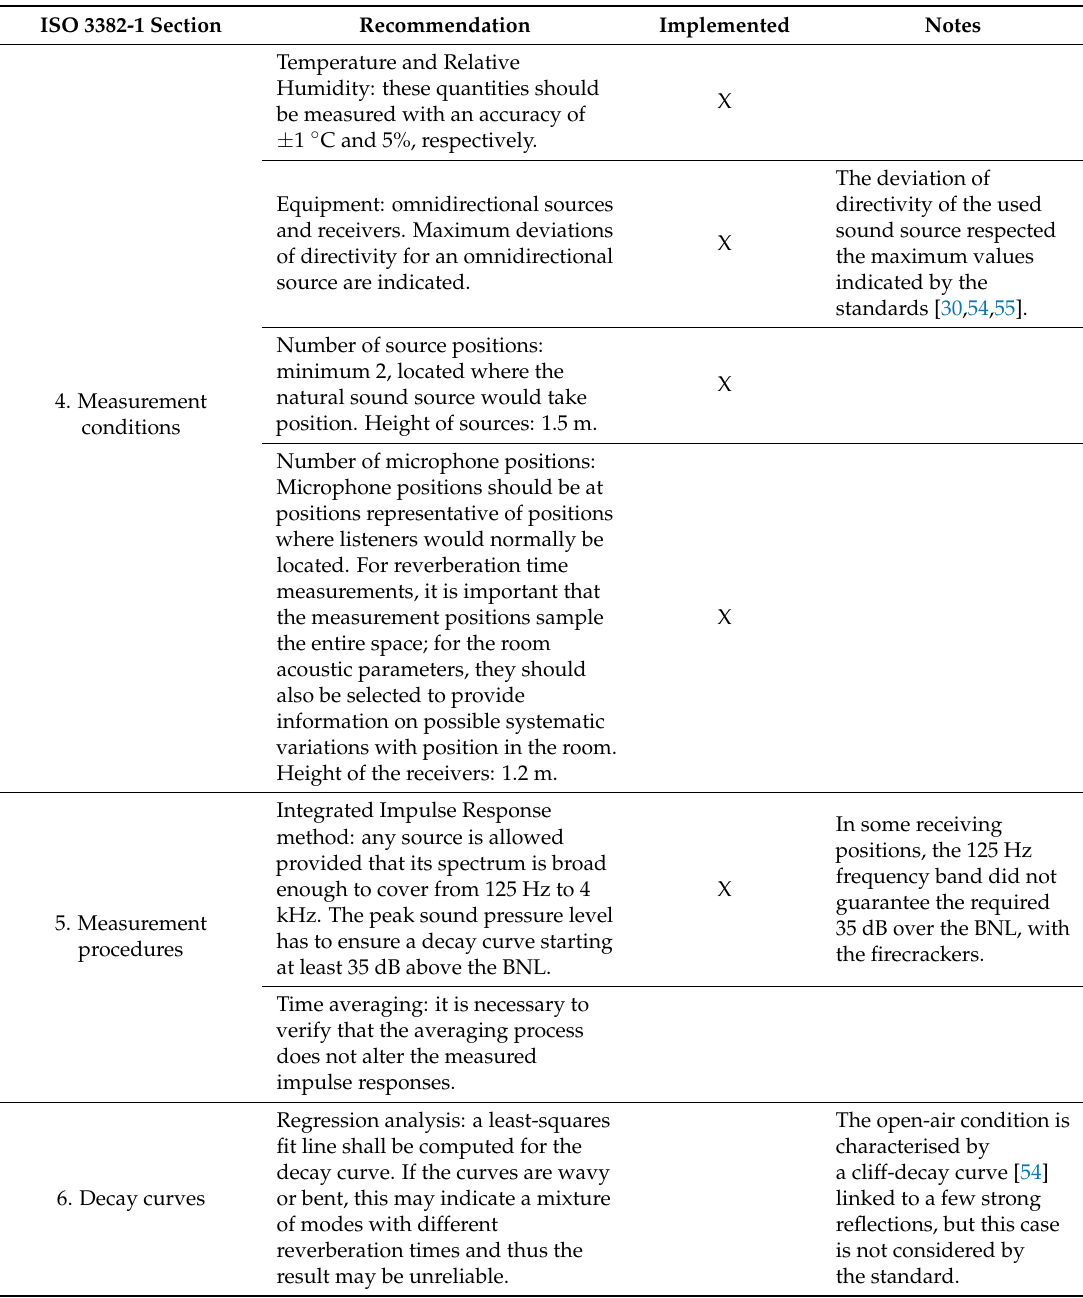
Table 5. ISO 3382-1 recommendations and their applications in the measurement campaign (X). ISO 3382-1